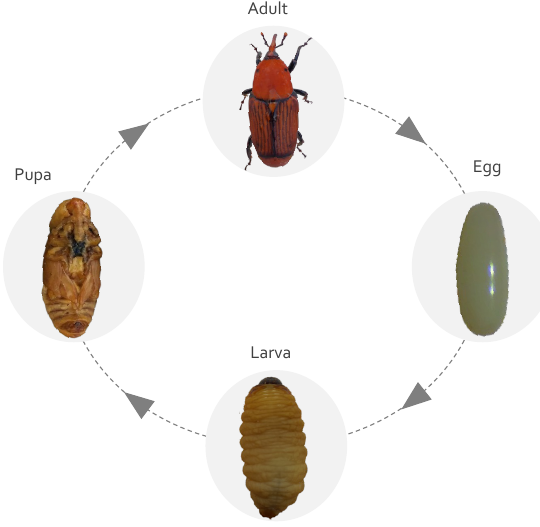
Figure 1. The life cycle stages of the red palm weevil, R. ferrugineus